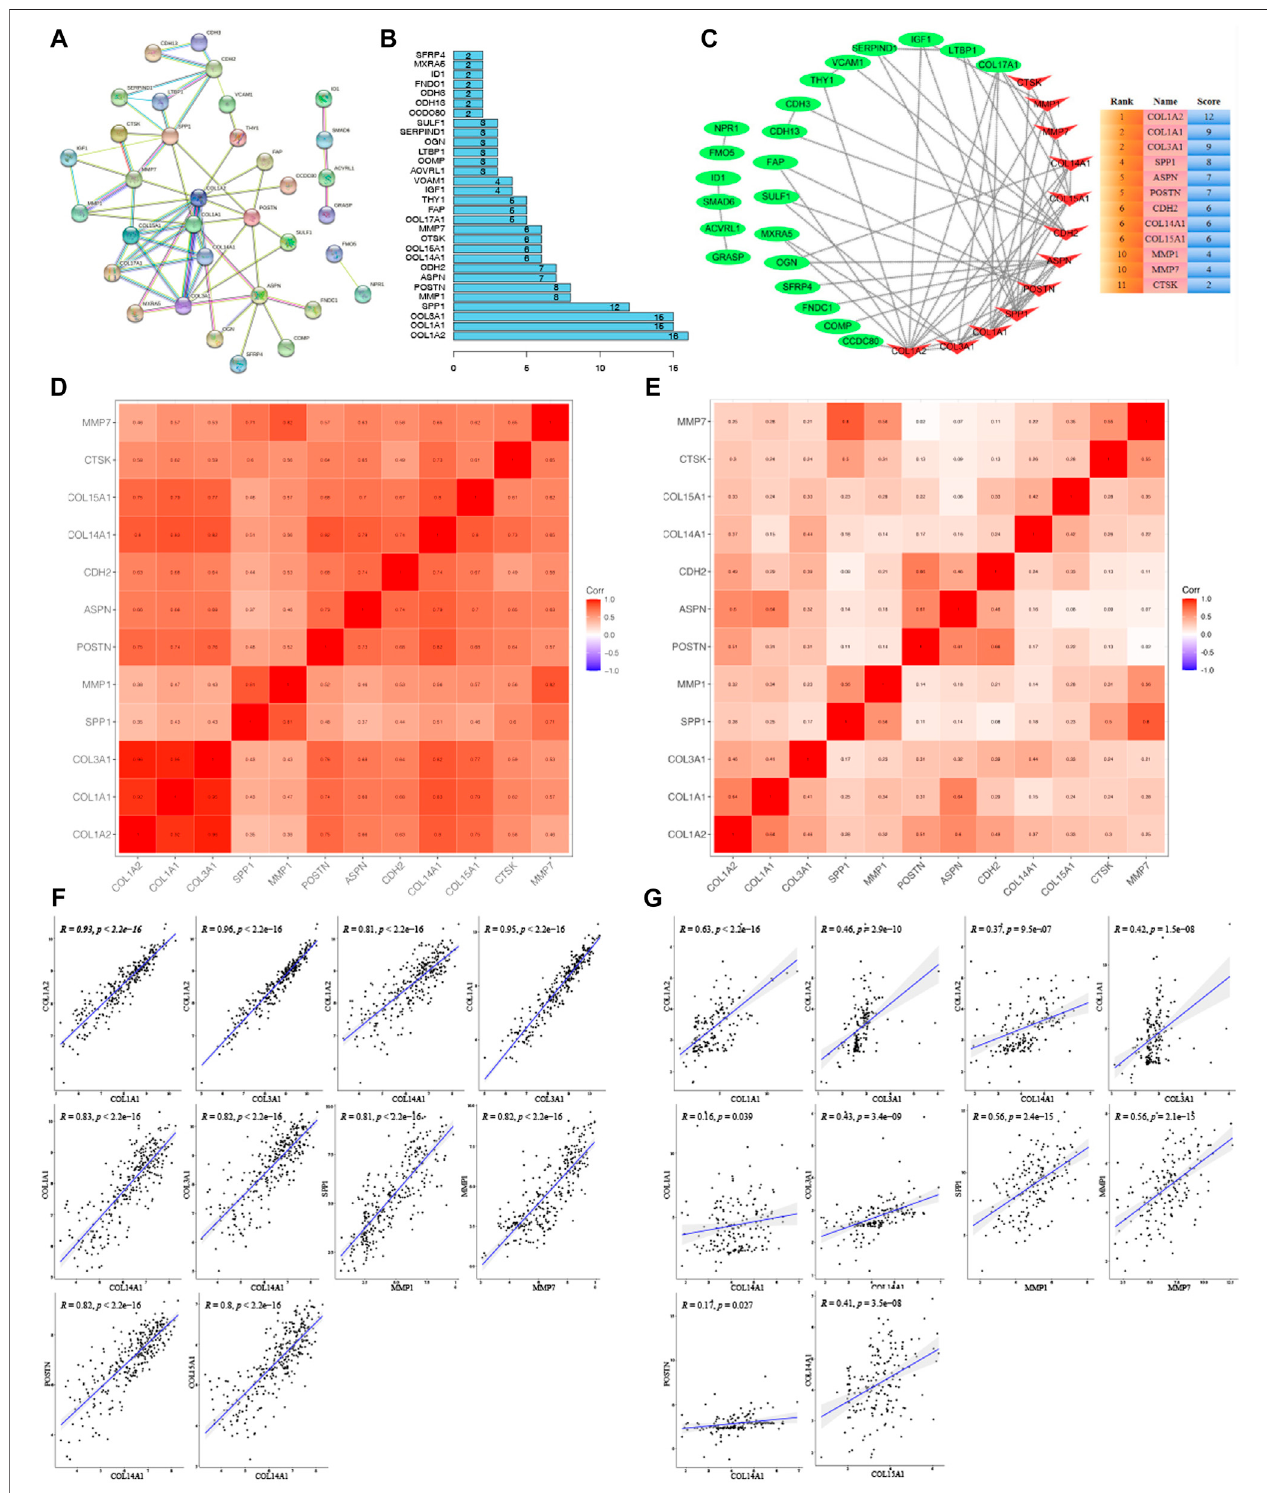
FIGURE5| ClusteranalysisofthePPInetworkinthetraininggroup. (A) Protein-proteininteraction(PPI)networkforkeygenes. (B) Histogramofkeygenes. (C) The hub gene network analyzed by Cytosacpe. (D) Correlation between hub genes in the training group. (E) Correlation between hub genes in the validation group. (F) Displayofcorrelationsbetweentengroupsofgeneswithacorrelationcoef fi cient > 0.8inthetraininggroup. (G) Displayofcorrelationsbetweentengroupsofgenesinthe validation group.